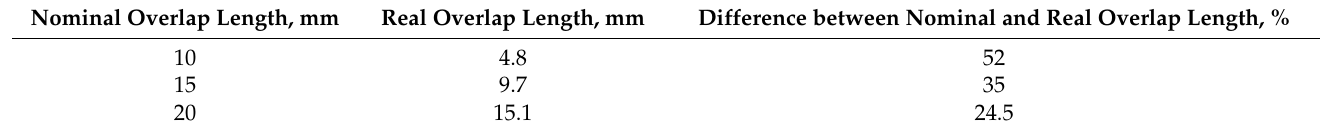
Table 4. Difference of the shear area